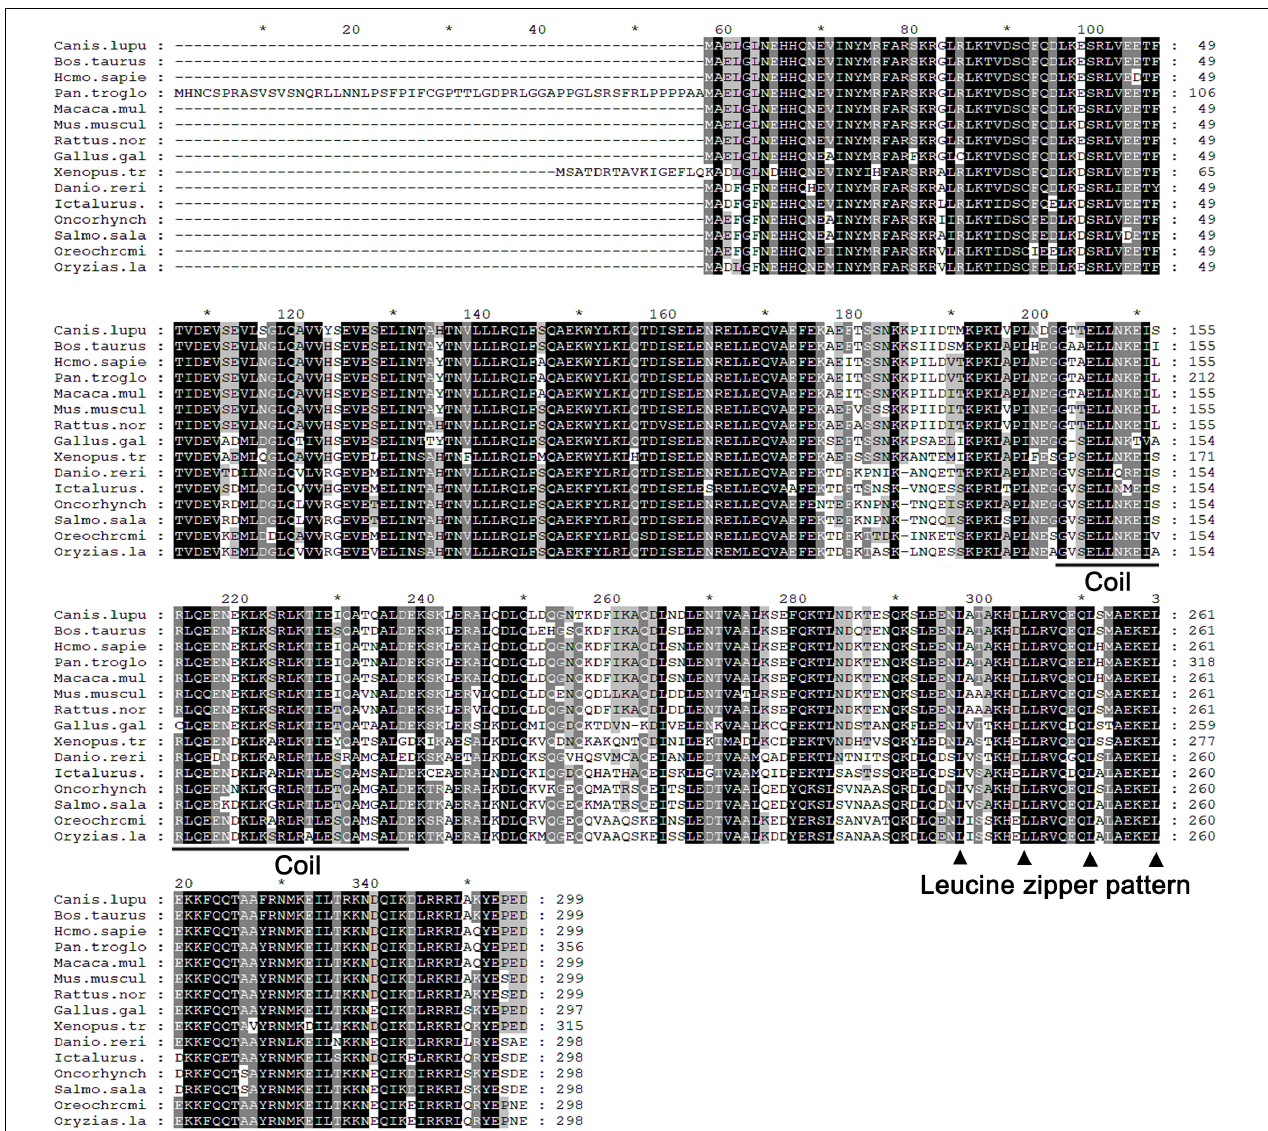
FIGURE 2 | Alignment of the predicted amino acid sequence of LZTFL1 genes among different species. Residues shaded in black are completely conserved across all species, and residues shaded in gray are similar with respect to the side chains. The dashes in the amino acid sequences indicate gaps introduced to maximize the alignment. The putative coil–coil domain was underlined. Four leucine residues, which constituted the “leucine zipper pattern,” were indicated by black